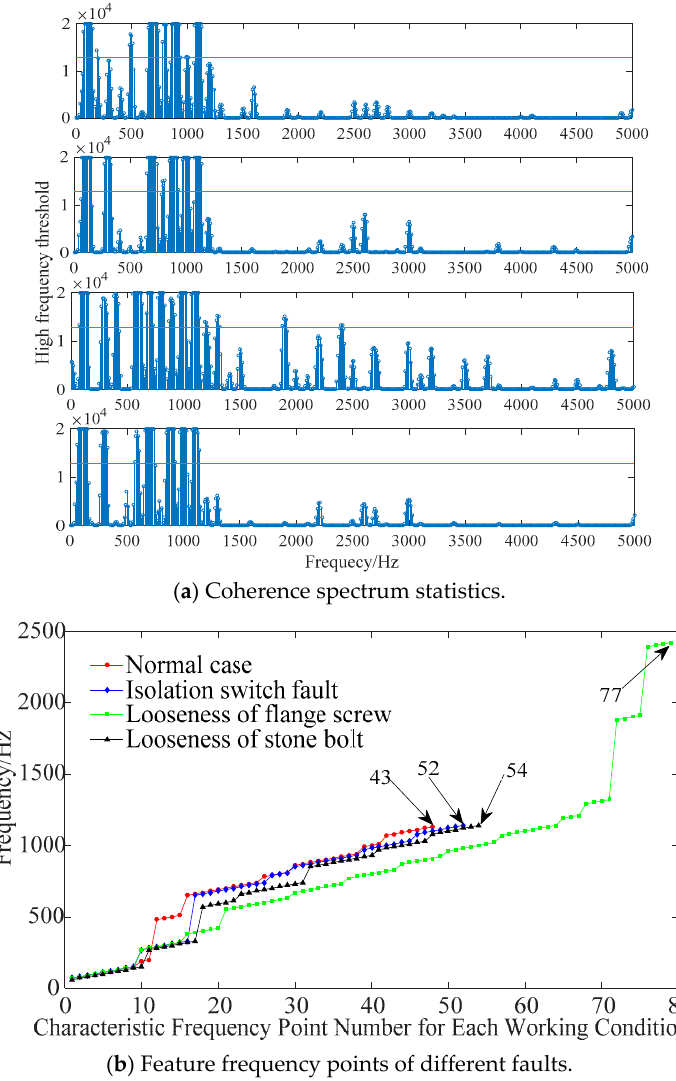
Figure 6. Characteristic distribution under different faults.